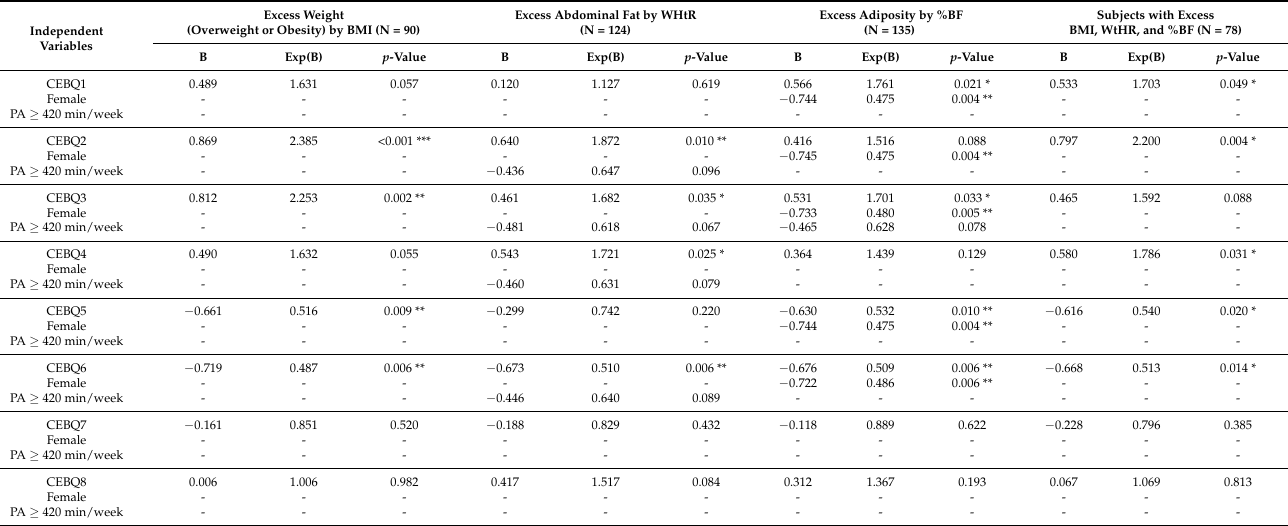
Table 3. Logistic regression analysis for the association between CEBQ subscales and nutritional